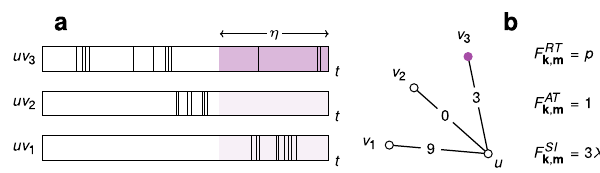
Fig. 1 Model of information transfer via bursty temporal interactions.